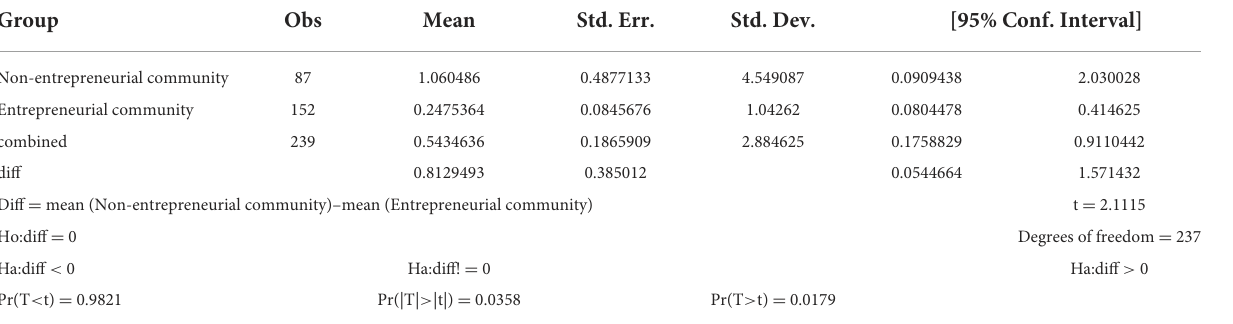
TABLE 6 T test results of the growth rate of community entrepreneurial industry cluster. Group Obs Mean Std. Err. Std. Dev. [95% Conf.